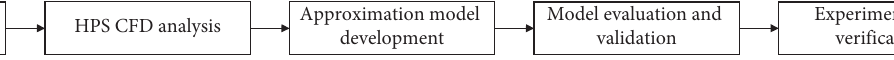
Figure 1: Flowchart of the overall mathematical modeling method of HPS.